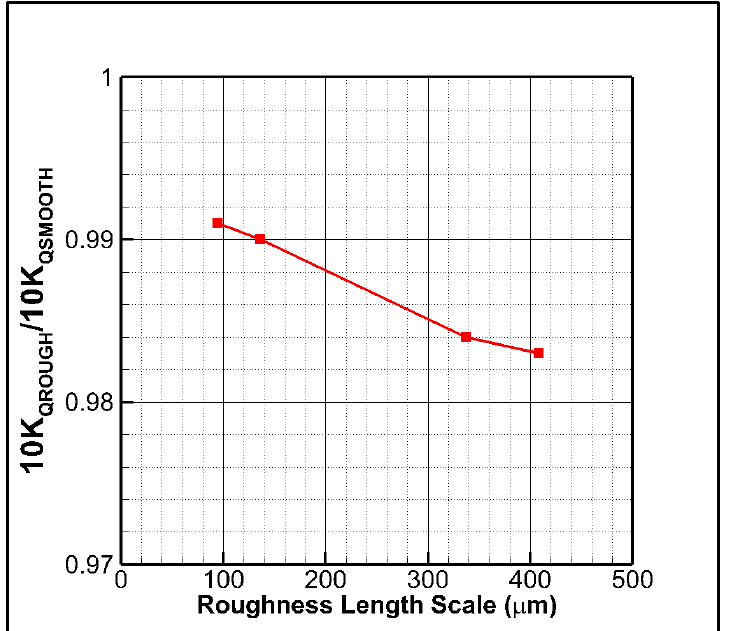
Figure 6. Change in torque coefficient (10𝐾 (cid:3018) ) with roughness.